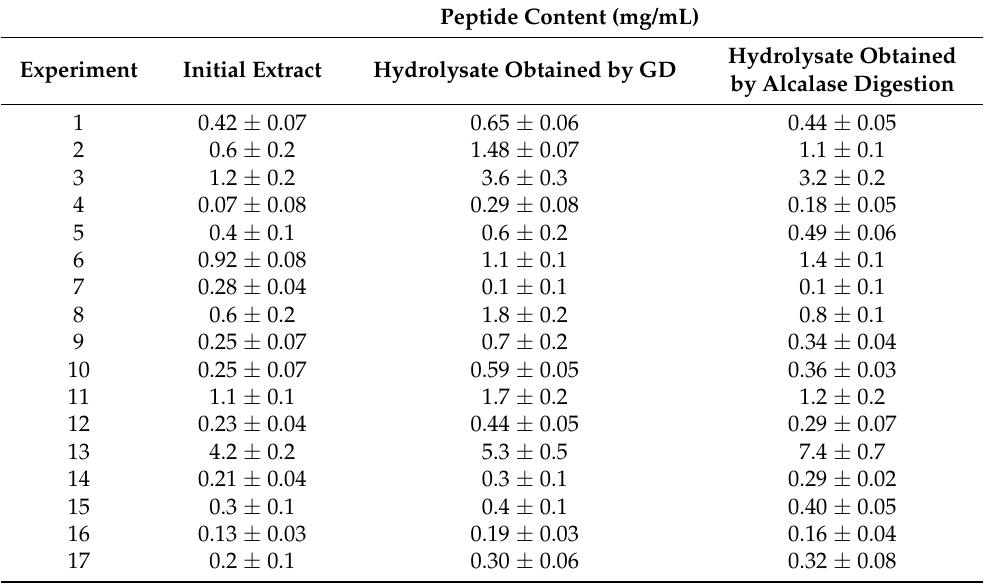
Table 3. Peptide content in the initial extracts and in the hydrolyzates obtained by gastrointestinal digestion (GD) or Alcalase